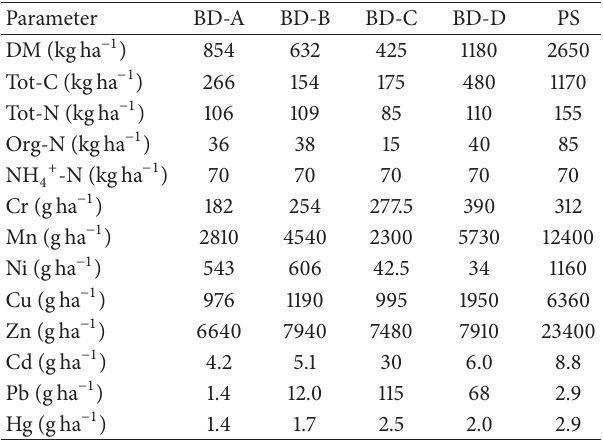
Table 4: Amount of dry matter (DM), heavy metals, and nutrients added at an amendment rate corresponding to 70 kg NH with the four types of biogas digestates (BD-A, BD-B, BD-C, and BD-D) and pig slurry